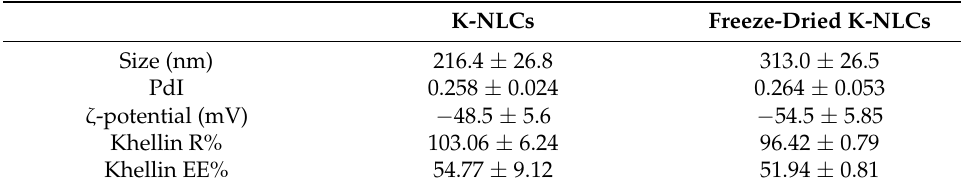
Table 2. Physical (size, PdI, and ζ -potential) and chemical (R% and EE%) characterization of K- NLCs and K-NLCs freeze-dried with 5% w / v D-trehalose dihydrate. Results are shown as the mean ± standard deviation ( n = 3).